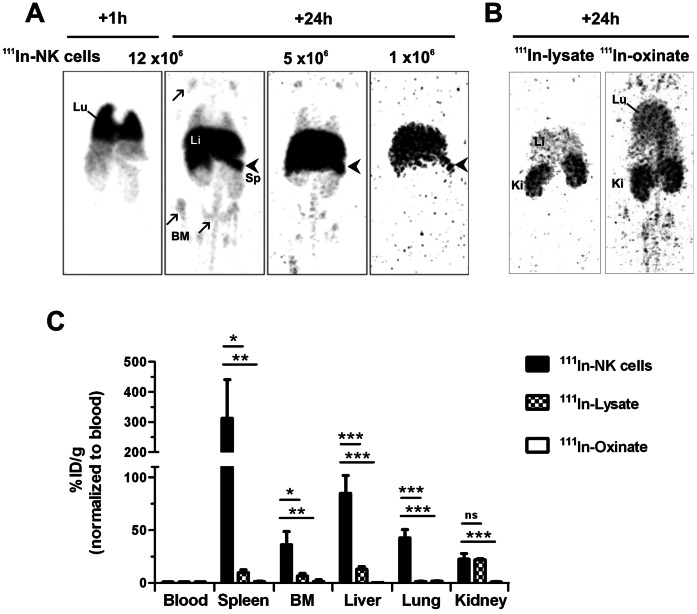
SPECT-CT imaging provides good sensitivity and specificity to track 111In-labeled UCB-NK cells in vivo
.
To address the feasibility of UCB-NK cell tracking in vivo, adult NSG mice were injected i.v. either with increasing doses of 111In-NK cells (1, 5 or 12×106
111In-NK cells per mouse equivalent to 1, 5 and 12 MBq respectively, n = 5 in total), with a lysate obtained from 111In-NK cells (111In-lysate, n = 2) or with 111In-oxinate (n = 3). (A) Representative whole body SPECT scans acquired 1 h and 24 h after injection of 111In-NK cells with major visualization of lungs (Lu), liver (Li), spleen (Sp, arrowhead) and bone marrow (BM, arrow). (B) Representative whole body SPECT scans acquired 24 h after injection of 111In-NK cell lysate or 111In-oxinate; kidneys (Ki), heart (He). (C) Quantitative biodistribution analysis performed 24 h after injection. For comparison, the relative 111In-content of each tissue of interest was normalized to blood. Data are shown as mean ± SD. *p<0.05, **p<0.01, ***p<0.001.